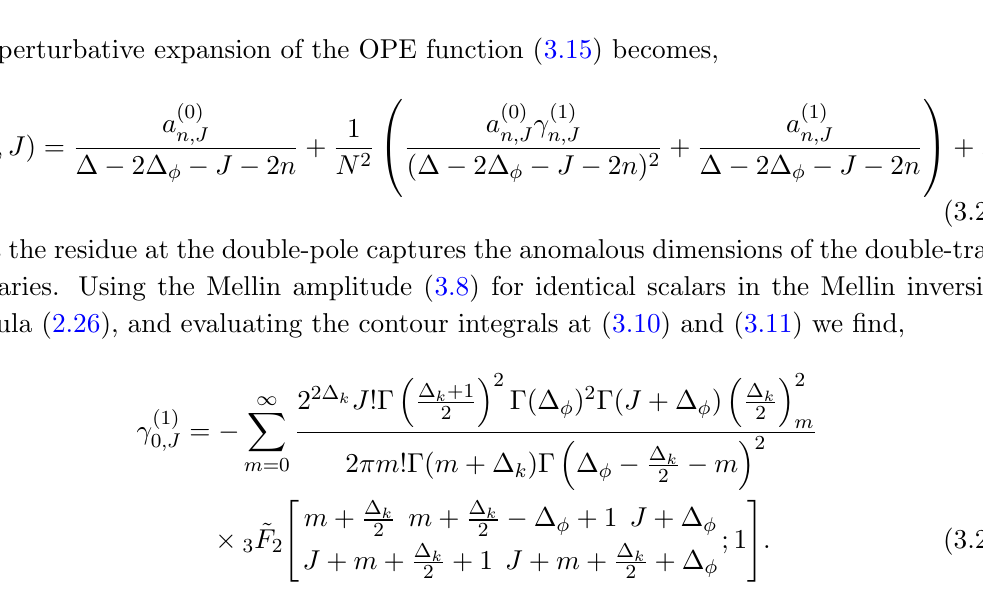
Figure 6 . The left panel is a plot of (cid:13) (1) ;us and (cid:13) 6 j when the satellite poles do not truncate for 0 ;J 0 ;J e.g. (cid:1) (cid:30) = 2 ; (cid:1) k = 3. We (cid:12)nd that our result, even when we sum over just the (cid:12)rst 2 satellite poles is indistinguishable from (cid:13) 6 j . On the right panel we plot the ratio (cid:13) 6 j for the case when we include (cid:13) us the (cid:12)rst 2 (yellow) and (cid:12)rst 5 (blue) satellite poles. As expected, the blue points are closer to 1 than yellow. Same holds true for other values of (cid:1) (cid:30) and (cid:1) k